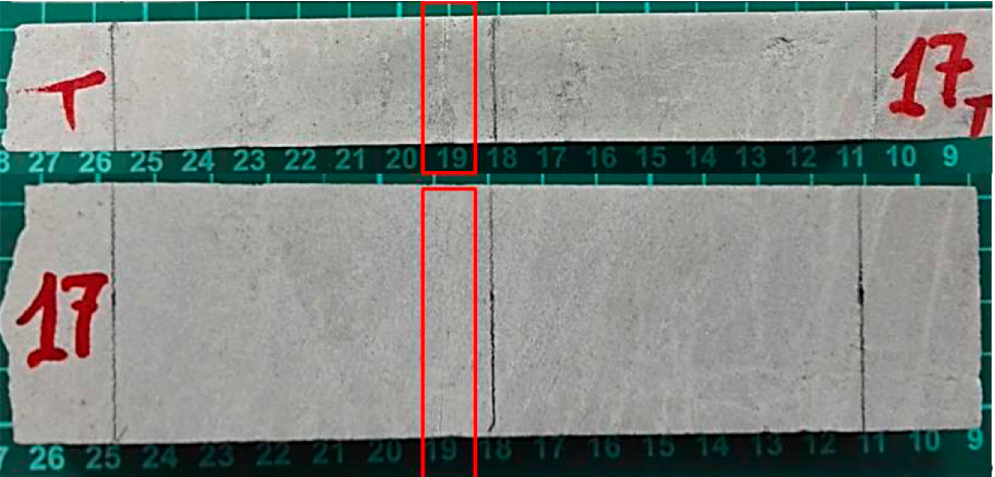
Figure 3. Set-up used for bending tests.